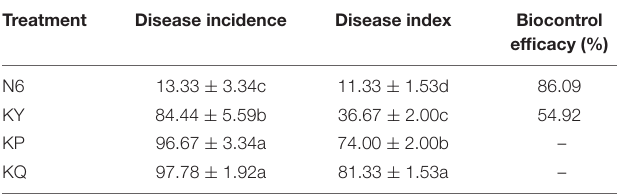
TABLE 3 | Disease incidence, disease index, and biocontrol efficacy. Treatment Disease incidence Disease